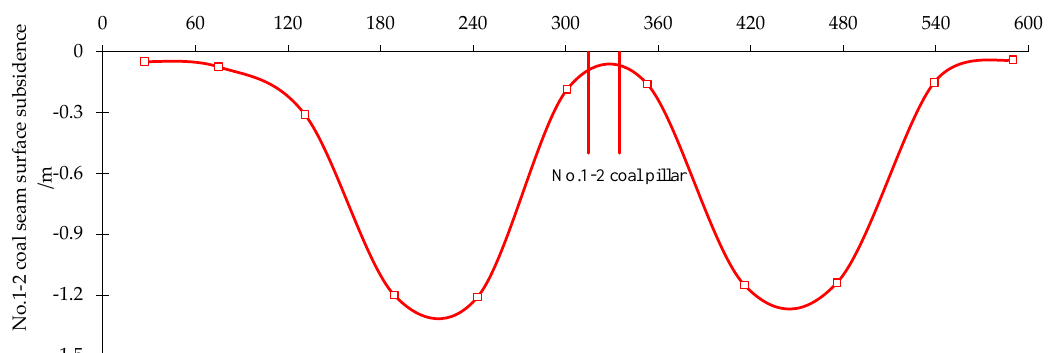
Figure 15. Surface “W - shape” subsidence curve after 1 -2 coal seam physical simulation mining.